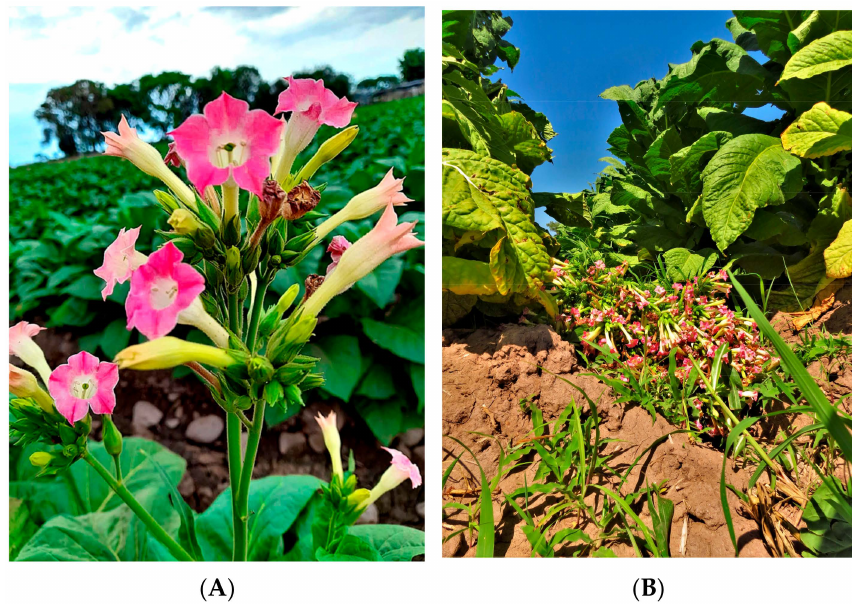
Figure 1. Nicotiana tabacum var. Virginia. ( A ) Inflorescences. ( B ) General aspect of pre-harvest waste produced during the blunt (inflorescence and apical leaves) and thrown in the field (Perico, Jujuy). Previous chemical studies revealed that tobacco flowers contained polysaccharides